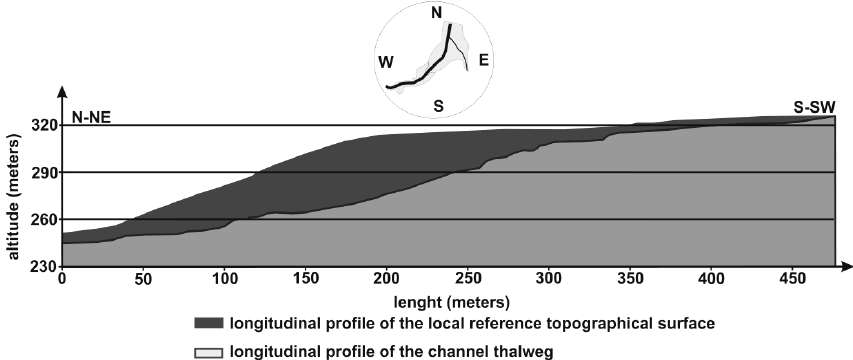
Fig. 9. Longitudinal profiles of all the surfaces and talwegs of the main Cucuteni-Băiceni gullies in 2008.